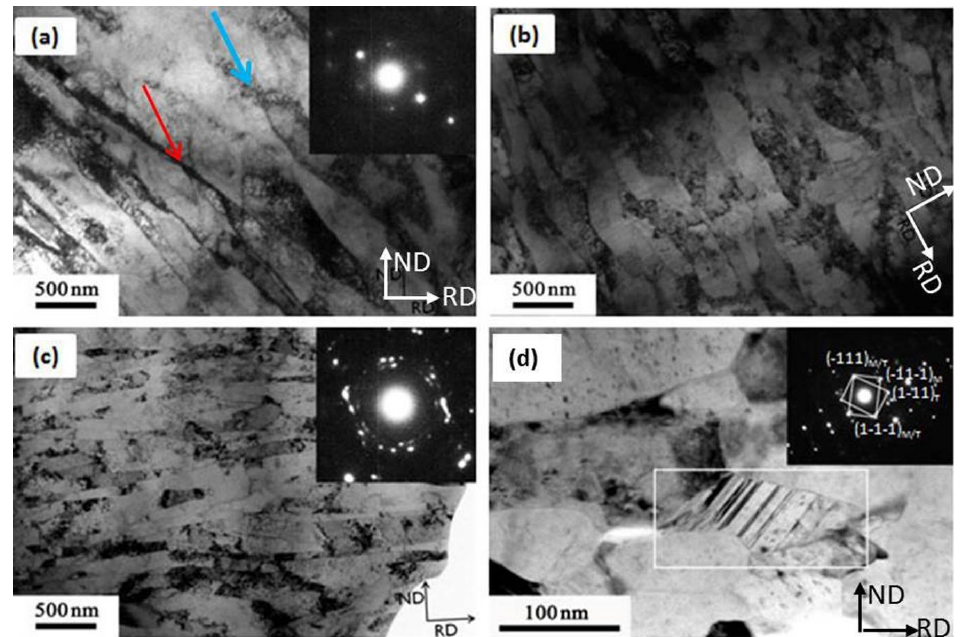
Figure 5. Bright-field TEM images of pure Cu after different ARB passes, ( a ) 1P, ( b ) 3P, ( c ), and ( d ) 6P; the selected area electron diffraction (SAED) patterns in ( a , c ) were obtained from a circle region of 750 nm in diameter, and the SAED pattern in ( d ) was obtained from a circle region of 200 nm in diameter.